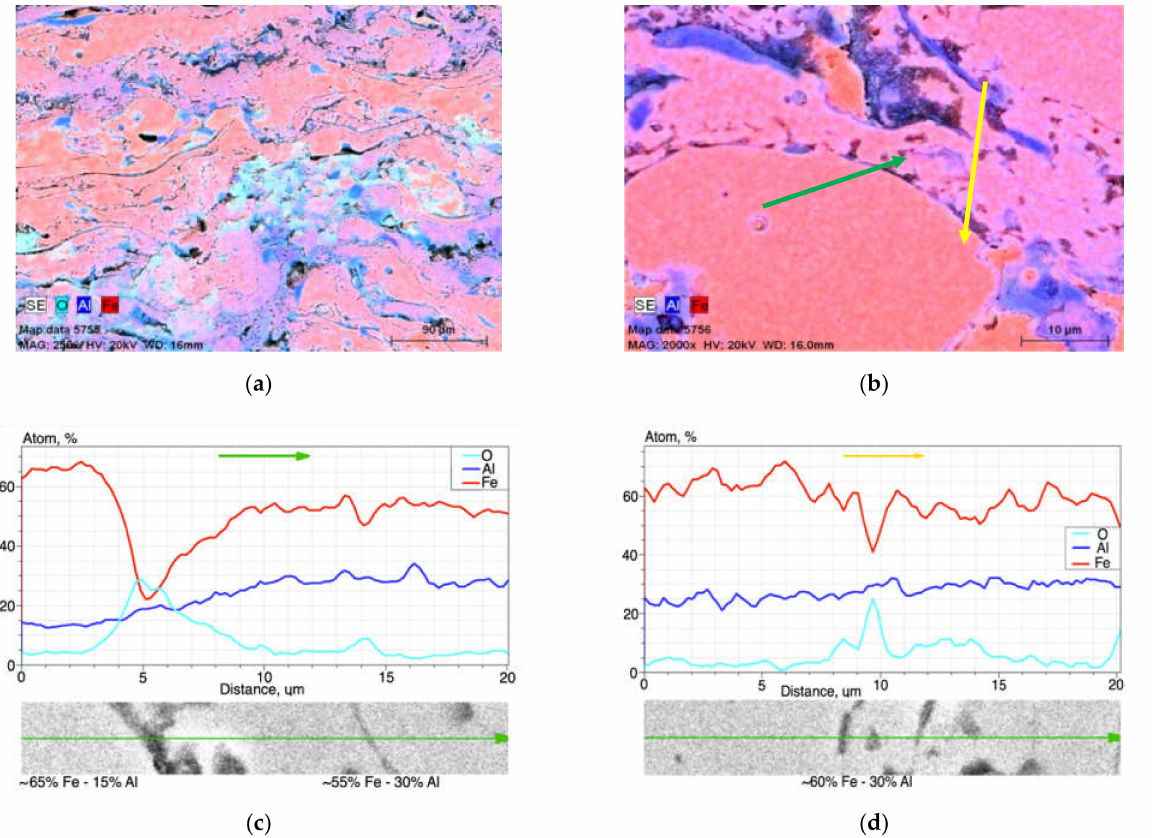
Figure 6. EDX results of elements distribution in cross-section of the coating annealed at 800 ◦ C: maps of ( a ) O, Al, and Fe and ( b ) Al and Fe, as well as plots of the linear distribution of elements along two lines, respectively—( c ) green and ( d ) yellow—as marked on ( b ). Table 2. Chemical composition of as-arc-sprayed Fe-Al-type coating after annealing at 800 ◦ C/2 h based on EDX point microanalysis according to Figure 5.